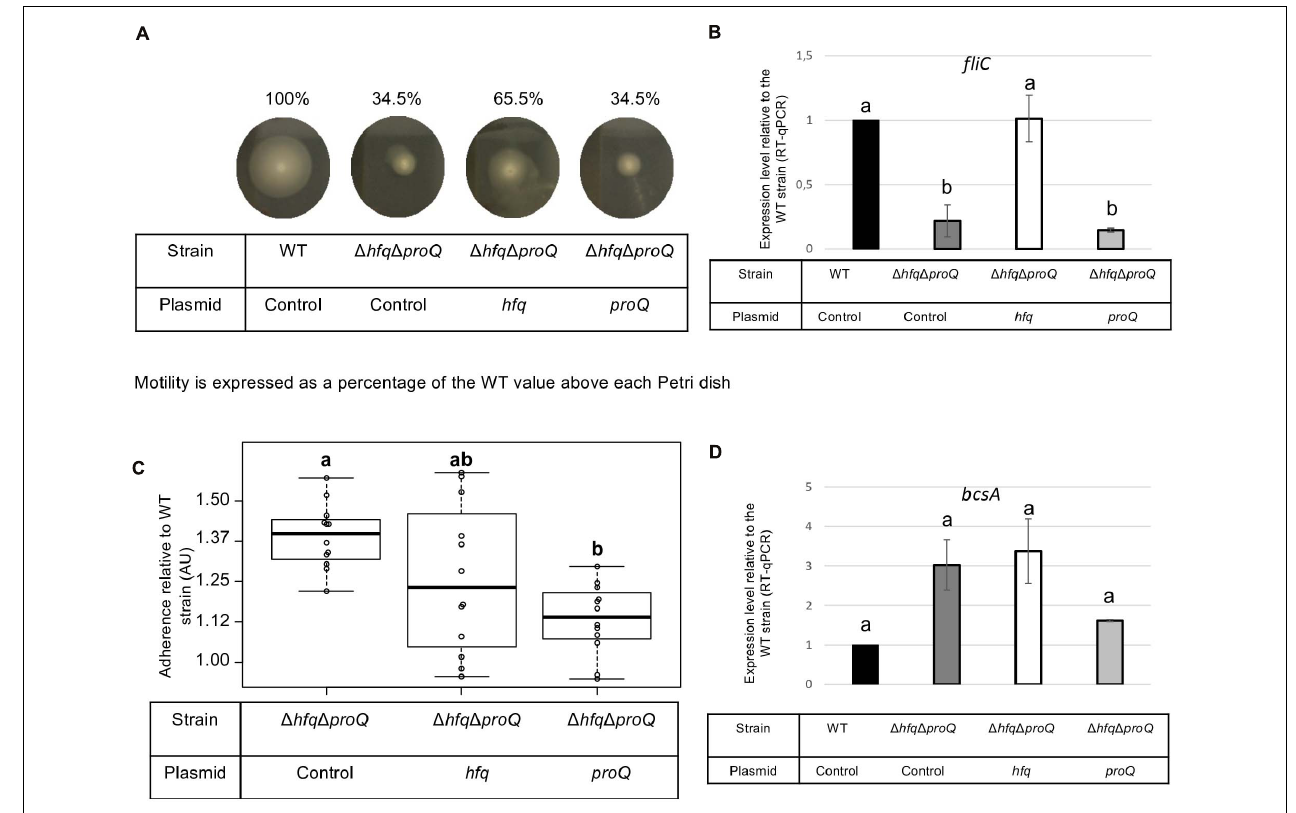
FIGURE 8 | Impact of the double mutant on early virulence factors. Phenotypes and expression levels were analyzed in the double mutant strain and the double mutant strain complemented by Hfq or ProQ. (A) Motility was evaluated on semi-solid LB agar plates; (B,D) Expression levels of genes were measured by RT-qPCR and compared with the wild type; (C) Adherence was evaluated and compared with the wild-type strain. Experiments were repeated at least three times. Non-capital letters a, b, c, and d are presented above the boxplots and histograms. Groups with the same letter are not detectably different (are in the same set) and groups that are detectably different get different letters (different sets). Groups can have more than one letter to reflect “overlap” between the sets of groups. Note that if the groups have the same letter, this does not mean they are the same, just that there is no evidence of a difference for that pair ( P < 0.05, Wilcoxon Mann-Whitney